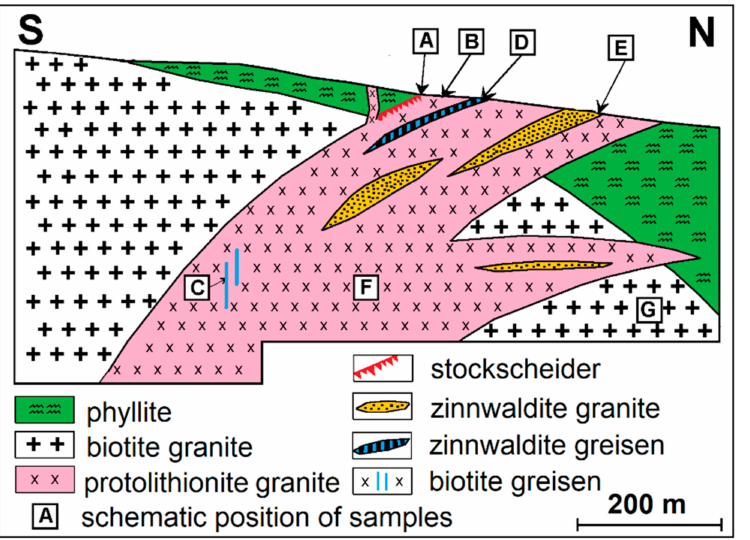
Figure 2. A simplified cross-section through the Podles í granite stock with positions of samples. For explanation of symbols A–G see the Table